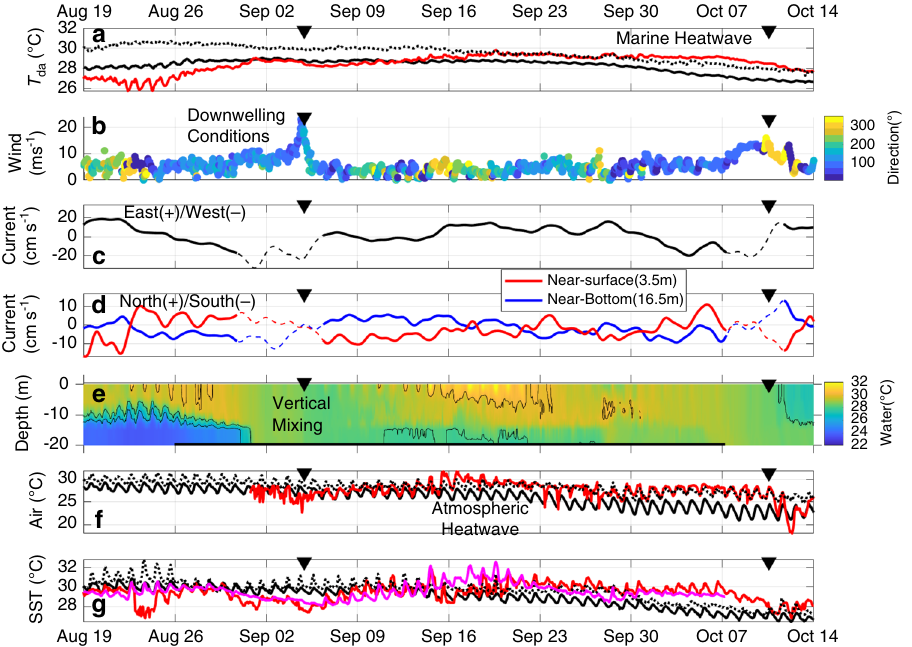
Fig. 2 Time series of observations. Time series during the fall of 2018 for a depth-average temperature at site CP (red), a proxy for shelf heat content, b wind speed and direction (coloration) at ORB with 0°/360° being a north wind, c along-shelf depth-average currents at site CP, d across-shelf currents at site CP, e vertical temperature structure at site CP, f air temperature at DI (red), and g SST at PCB (red) and site CP (magenta), with the inverse triangles at the top indicating the landfall times of TS Gordon (9/4/2018) and Hurricane Michael (10/10/2018). Also shown in ( a ), ( f ), and ( g ) are the long-term mean (black line) and the 90th percentile threshold (dotted line) based on 13, 32, and 5 – 9 years of data, respectively. In ( b ), the blue (yellow) colors indicate downwelling (upwelling) conditions. In ( c ) and ( d ), the thin dashed lines indicate the periods associated with potentially low-quality data due to movement of the AWAC instrument. In ( e ), the black contours indicate isotherms (26, 28, and 30 °C) and horizontal black line at the bottom indicates the time period of the model simulations (cases A1 – A3 in Table